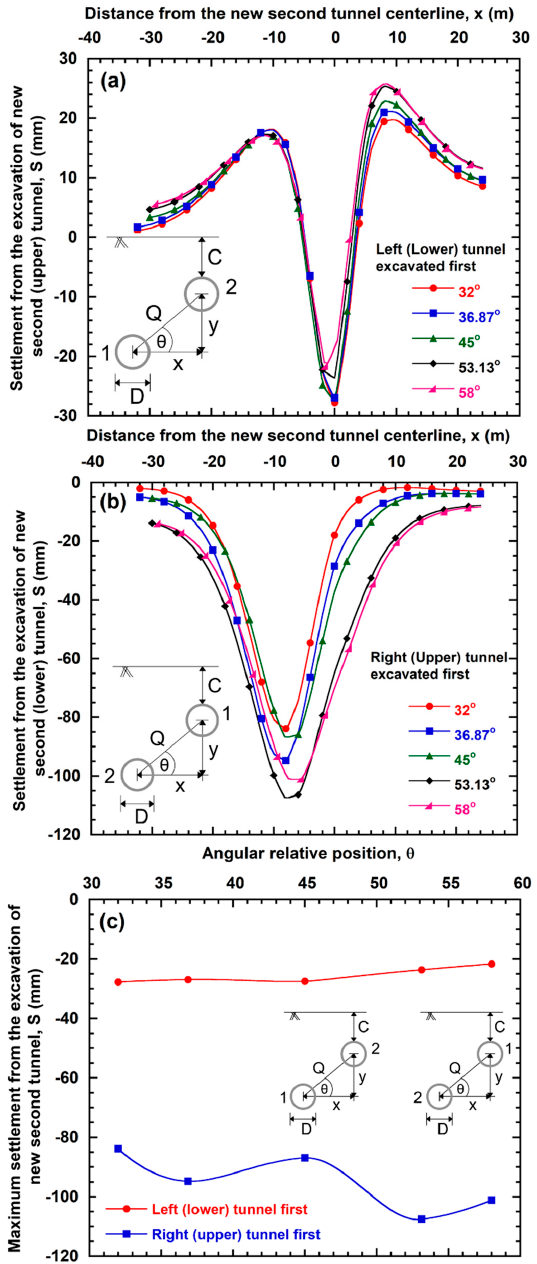
Figure 10. Effect of angular relative position on ( a , b ) surface settlement above the new second tunnel and ( c ) maximum settlement from the excavation of the new second tunnel.